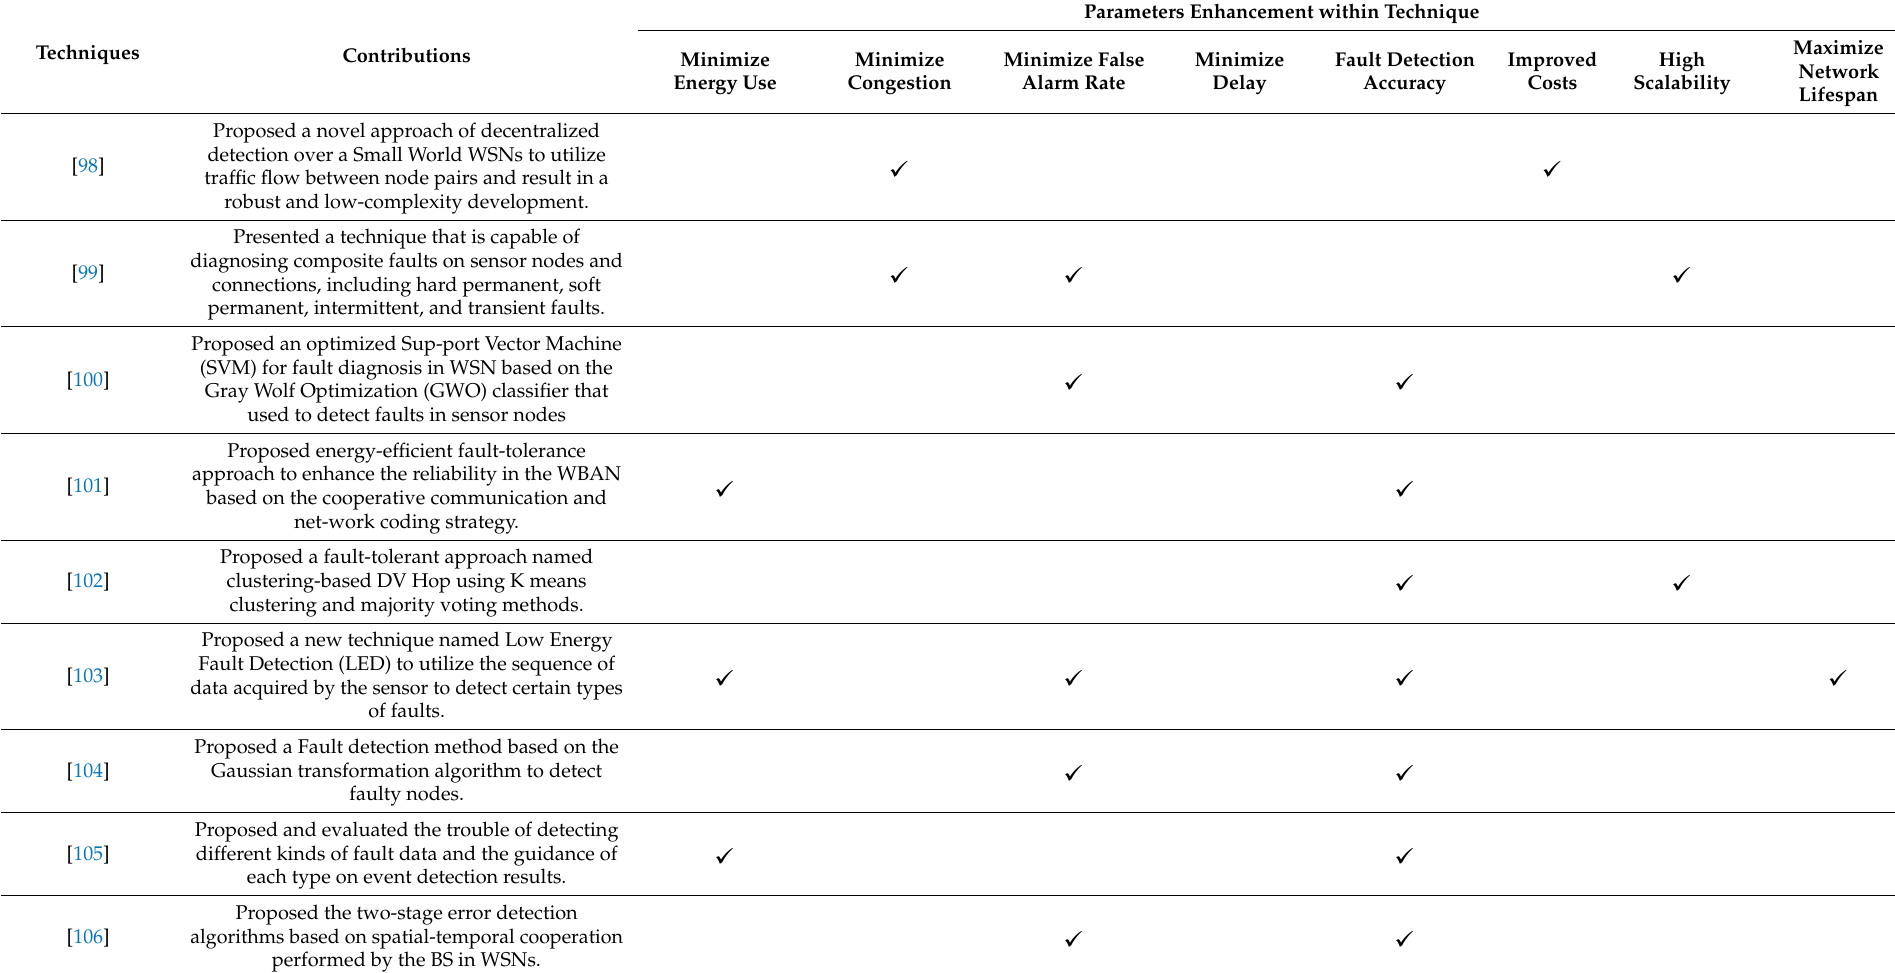
Table A1. Cont. Table 1. Surveys on Fault-Tolerant in WSNs. Table 1. Surveys on Fault-Tolerant in WSNs.